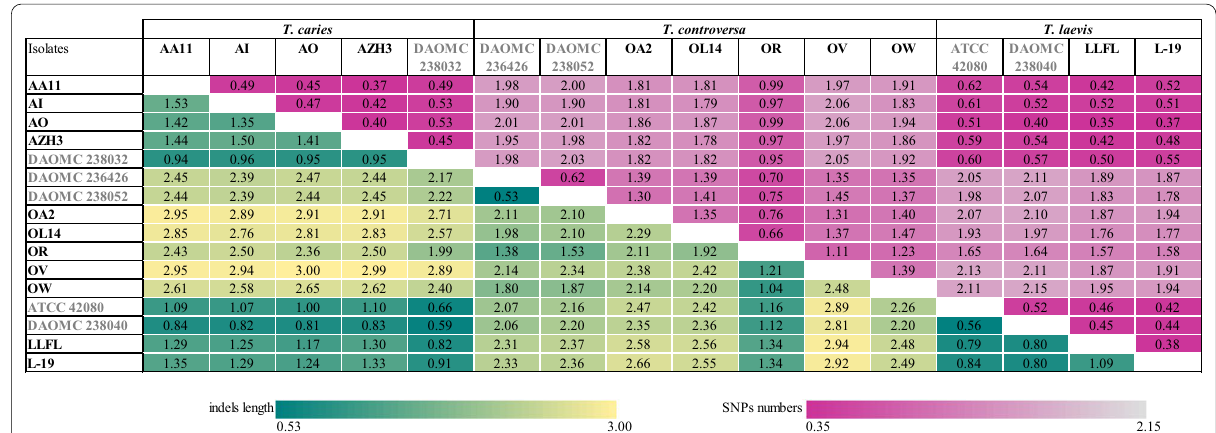
Fig. 4 The number of SNPs per kb (upper triangle) and the total length of indels per kb (lower triangle) in the repeat masked genomes of 16 isolates of common and dwarf bunt using NUCmer. The isolates and species are given as row and column labels where the sequenced genomes in this study are presented in black. Density of the SNPs and indels are represented by two color scales